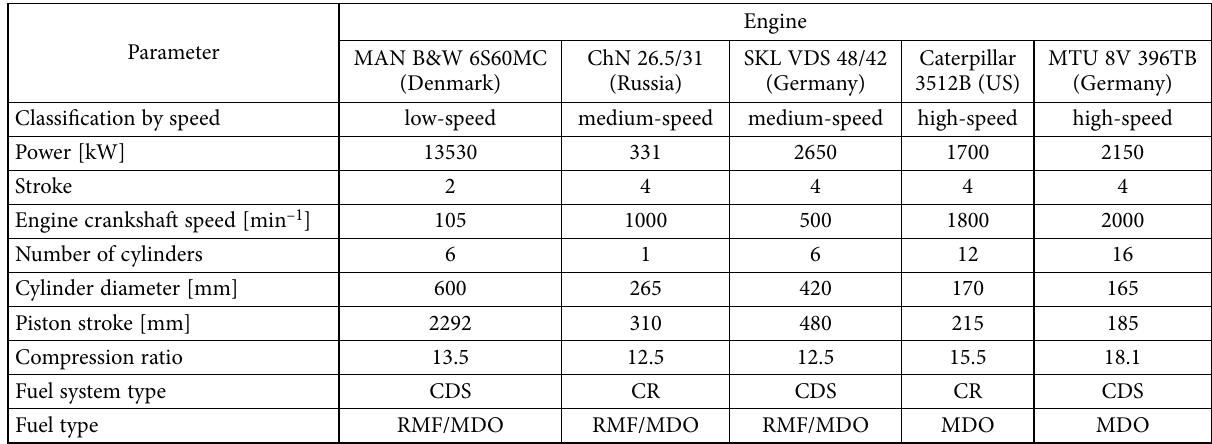
Figure 1. Parameters of selected fuel for engine modelling process Table 1. Parameters of researched